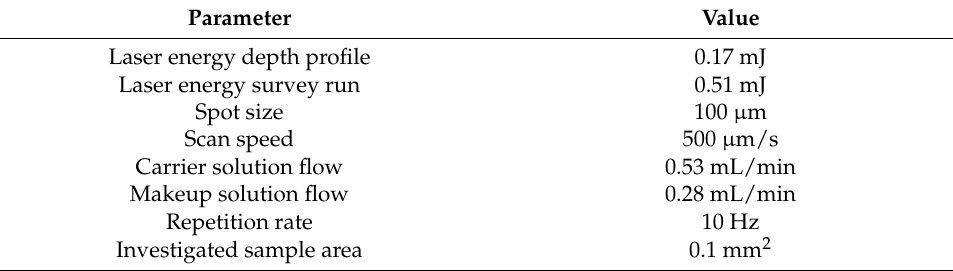
Table 3. Laser parameters for the online-LASIL